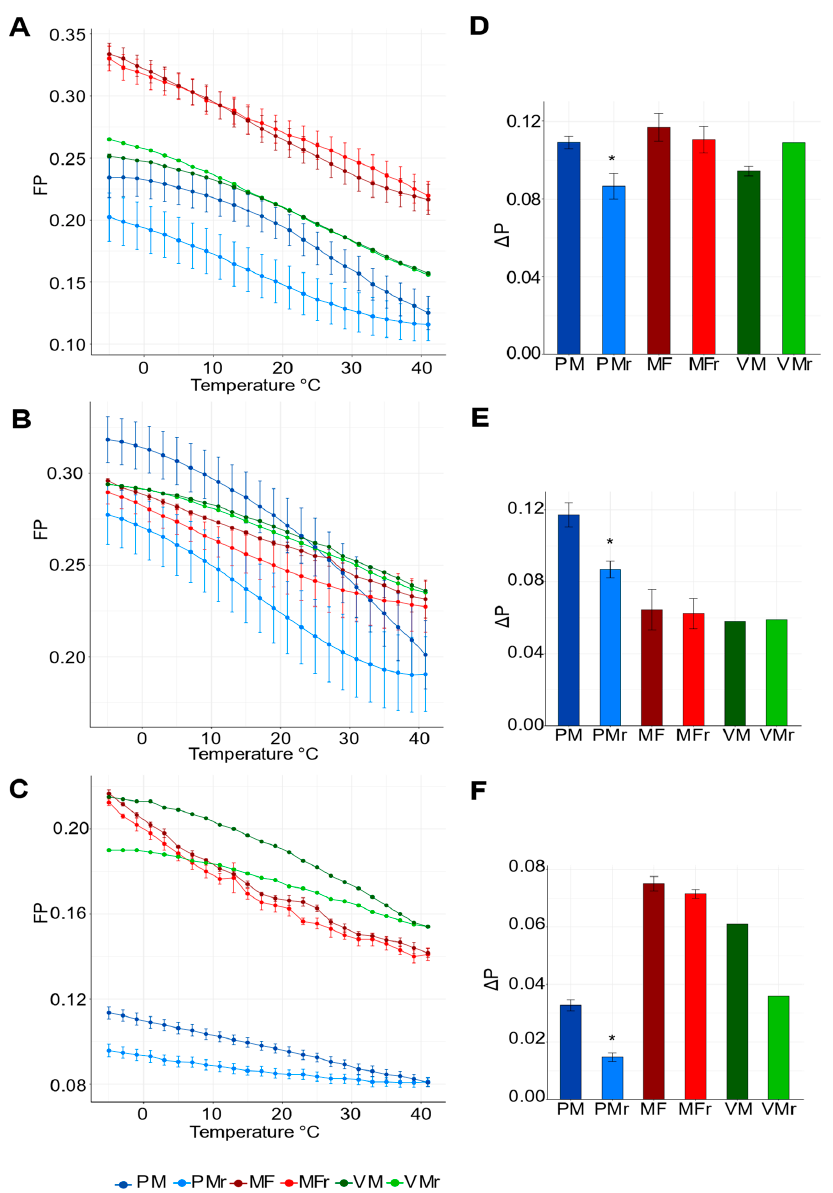
Figure 3. Effect of temperature on membrane fluidity (monitored as fluorescence polarization, FP) of microsomal fraction (MF), vacuolar membrane (VM), and isolated plasma membrane (PM). FP profile of MF (red, mean ± SEM n = 4), VM (green, mean ± SEM n = 2) and isolated PM (blue, mean ± SEM n = 5) from wild type plants using ( A ) DPH, ( B ) TMA-DPH, or ( C ) PA as membrane fluidity probes. Dark color represents data collected while warming membranes (MF, VM, PM from − 5 to 41 ◦ C) and the light color for cooling membranes (MFr, VMr, PMr from 41 to − 5 ◦ C). Total difference of FP, ∆ P values (final FP value – first FP value of every curve shown on the left side panel), of MF, VM, and PM using ( D ) DPH, ( E ) TMA-DPH, or ( F ) PA. Statistical differences were calculated using a two-tailed t-test comparing the cooling and heating conditions, * p < 0.05. See Materials and Methods for details on the FP set